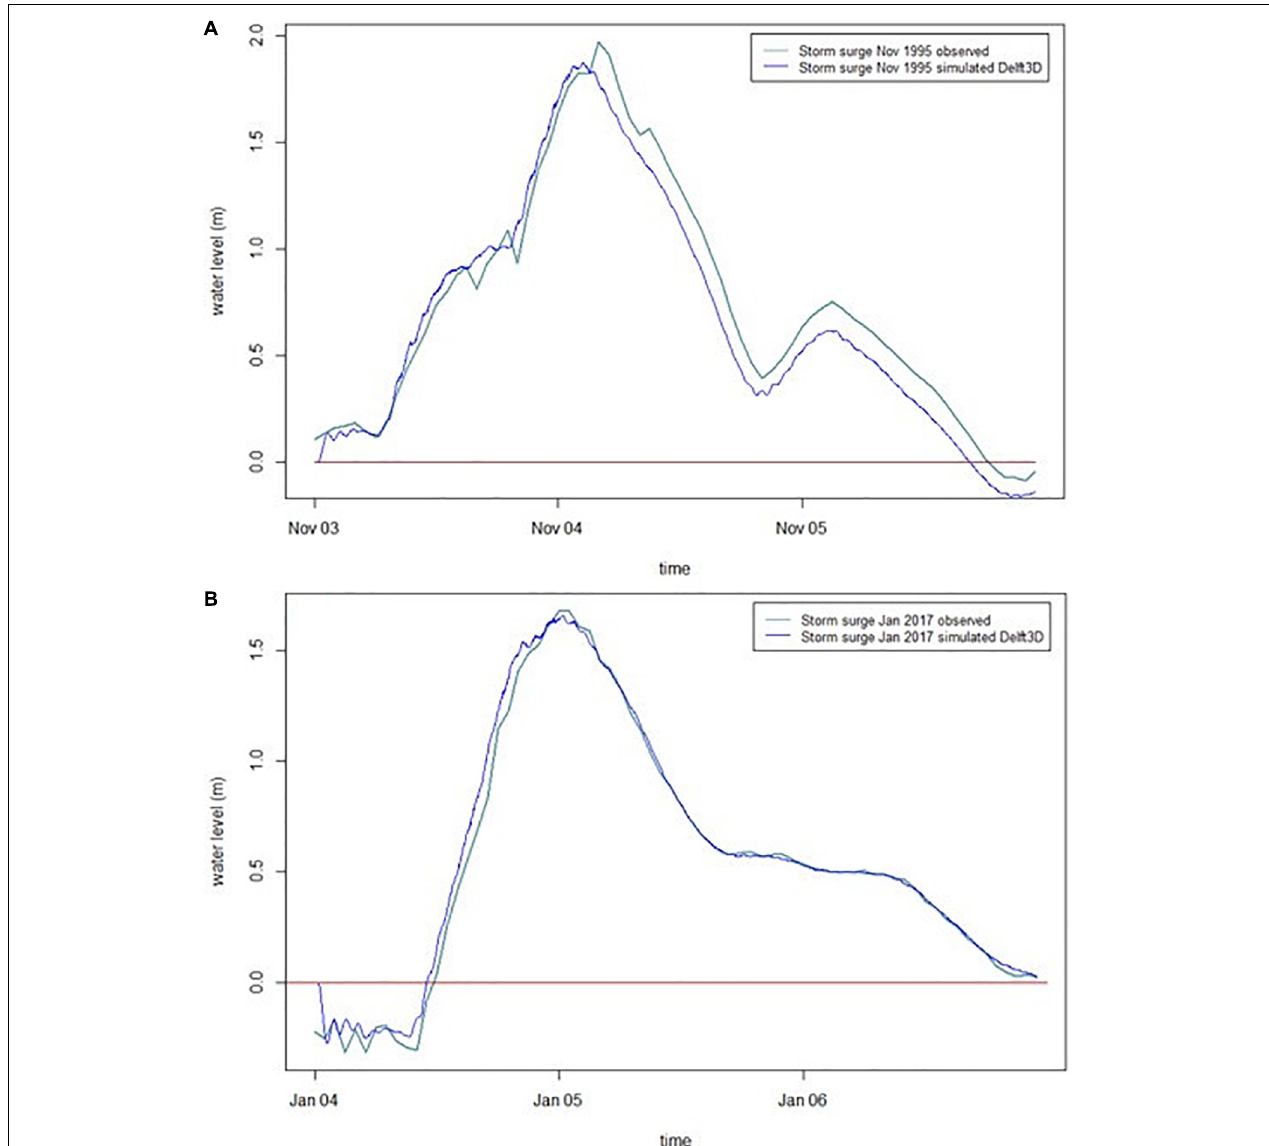
FIGURE 2 | Comparison of observed and simulated water levels November 1995 (A) and January 2017 (B) at the tide gauge